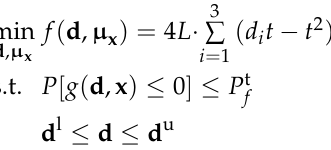
Table 7. Target failure probability and parameters for the reliability analysis and optimization.